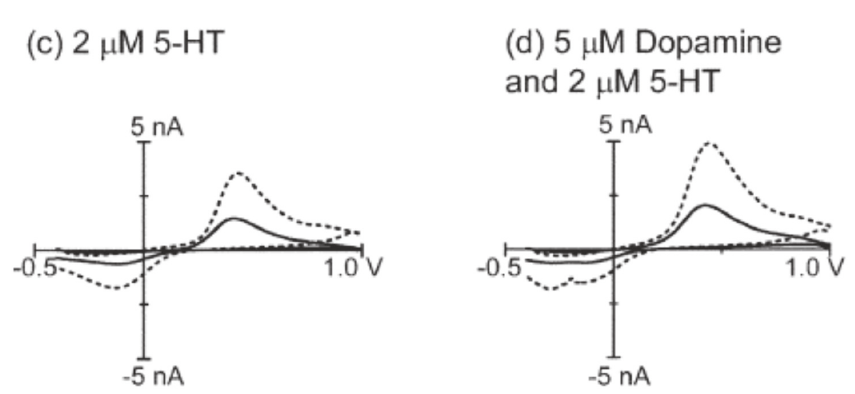
Figure 4: Comparison between bare (solid line) and CNT coated (dashed line) disk electrodes. (c) Background subtracted CVs for 2 𝜇 M serotonin. (d) Background subtracted CVs for 2 𝜇 M serotonin and 5 𝜇 M dopamine [17]. Reprinted from